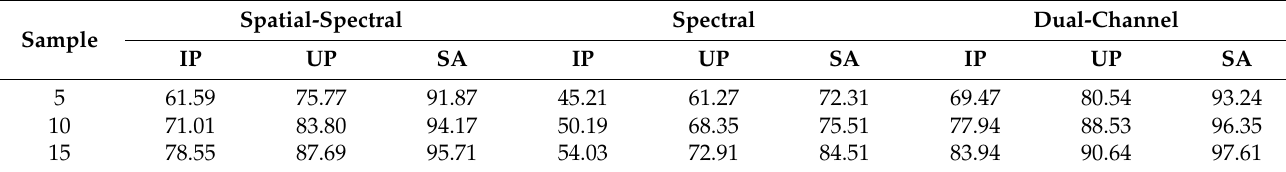
Table 7. Experimental results using spatial–spectral channel, spectrum channel, and dual-channel under 5, 10, and 15 training samples per class from IP, UP, and SA, respectively